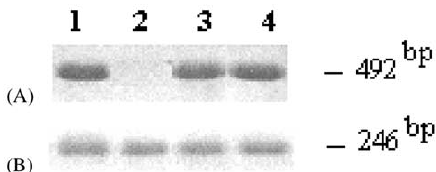
FIG. 2. FasL expression on CD4 and CD8 T cells. Lympho- cytes from BAL were separated into CD4 (cid:2) and CD8 (cid:2) subsets by positive selection using antibody-coated magnetic beads. The expression of FasL (A) and b -actin (B) on phytohaemag- glutinin (PHA)-stimulated BAL lymphocytes from silicosis patients (lane 1), PHA-stimulated BAL lymphocytes from healthy controls (lane 2), and separated CD4 (cid:2) (lane 3) and CD8 (cid:2) (lane 4) T cells were examined by reverse transcrip- tion-PCR and followed Southern blot analysis as described in Materials and methods. bp, base